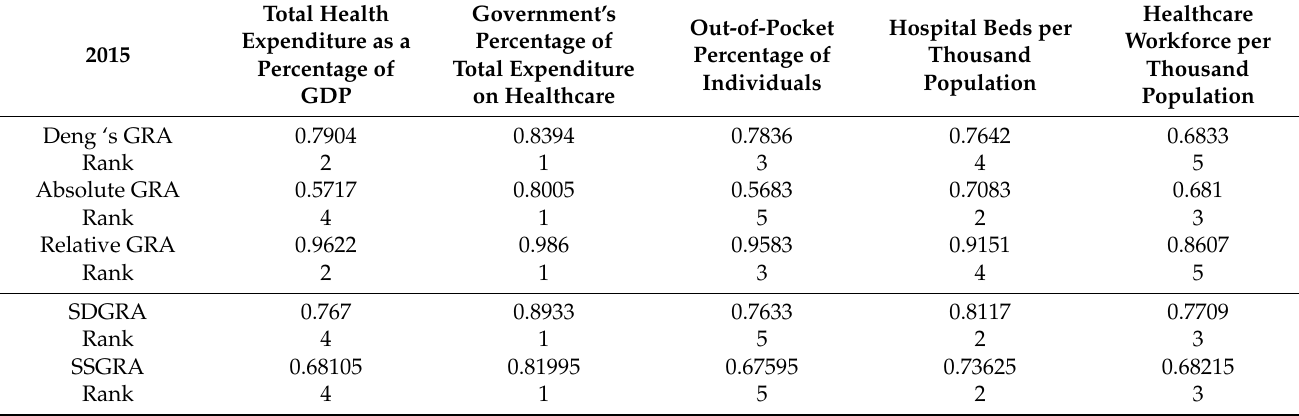
Table 4. Grey Relation Degree and Ranking of the Healthcare Resource Factors for Public Satisfaction with Health System in China (Year